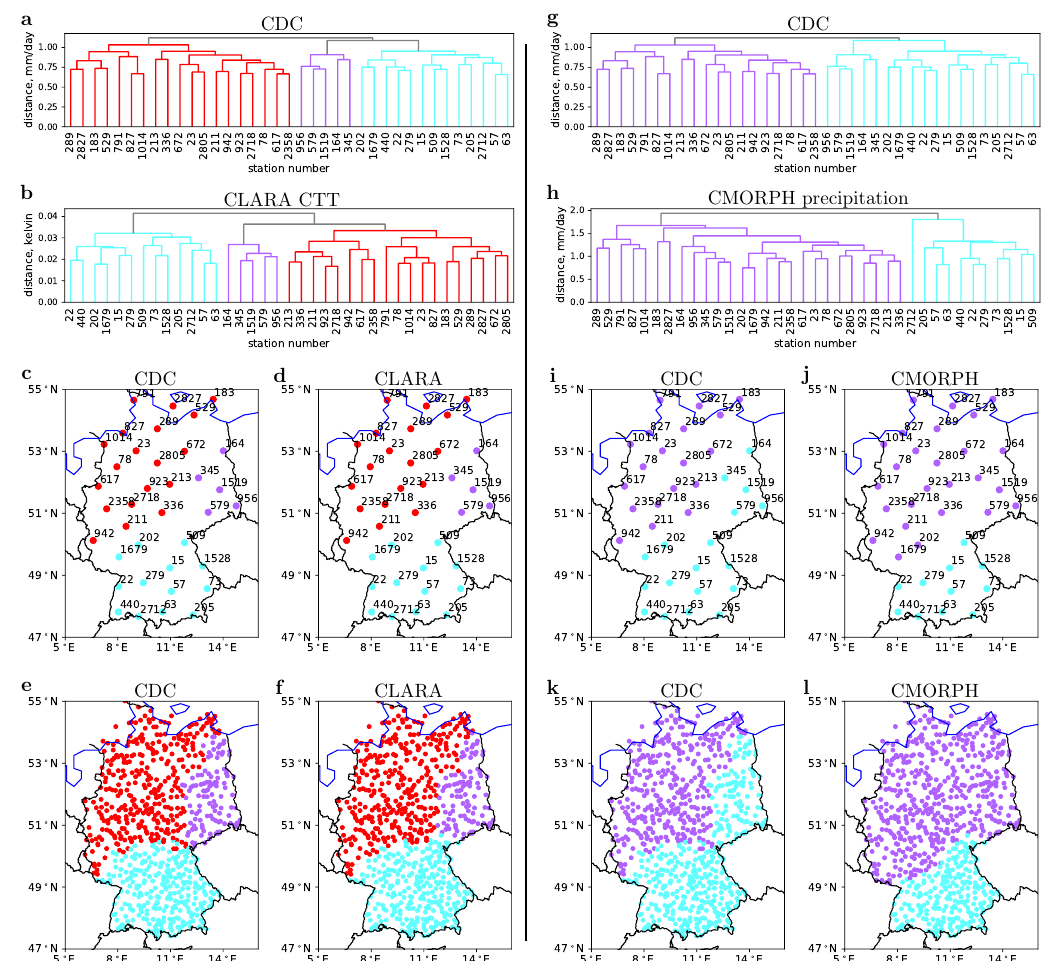
Figure 3. Dendrograms, clustering, and classification results using daily time series from CLARA CTT, CMORPH precipitation, and CDC stations over Germany. ( a , b ) Dendrograms based on CDC and CLARA, respectively. ( c , d ) Clustering of 37 CDC station locations using CDC and CLARA data, respectively. ( e , f ) Classifications of 691 CDC station locations using CDC and CLARA data over Germany. ( g , h ) Dendrograms based on CDC and CMORPH, respectively. ( i , j ) Clustering of CDC stations using CDC and CMORPH data, respectively. ( k , l ) Classification of CDC stations using CDC and CMORPH data over